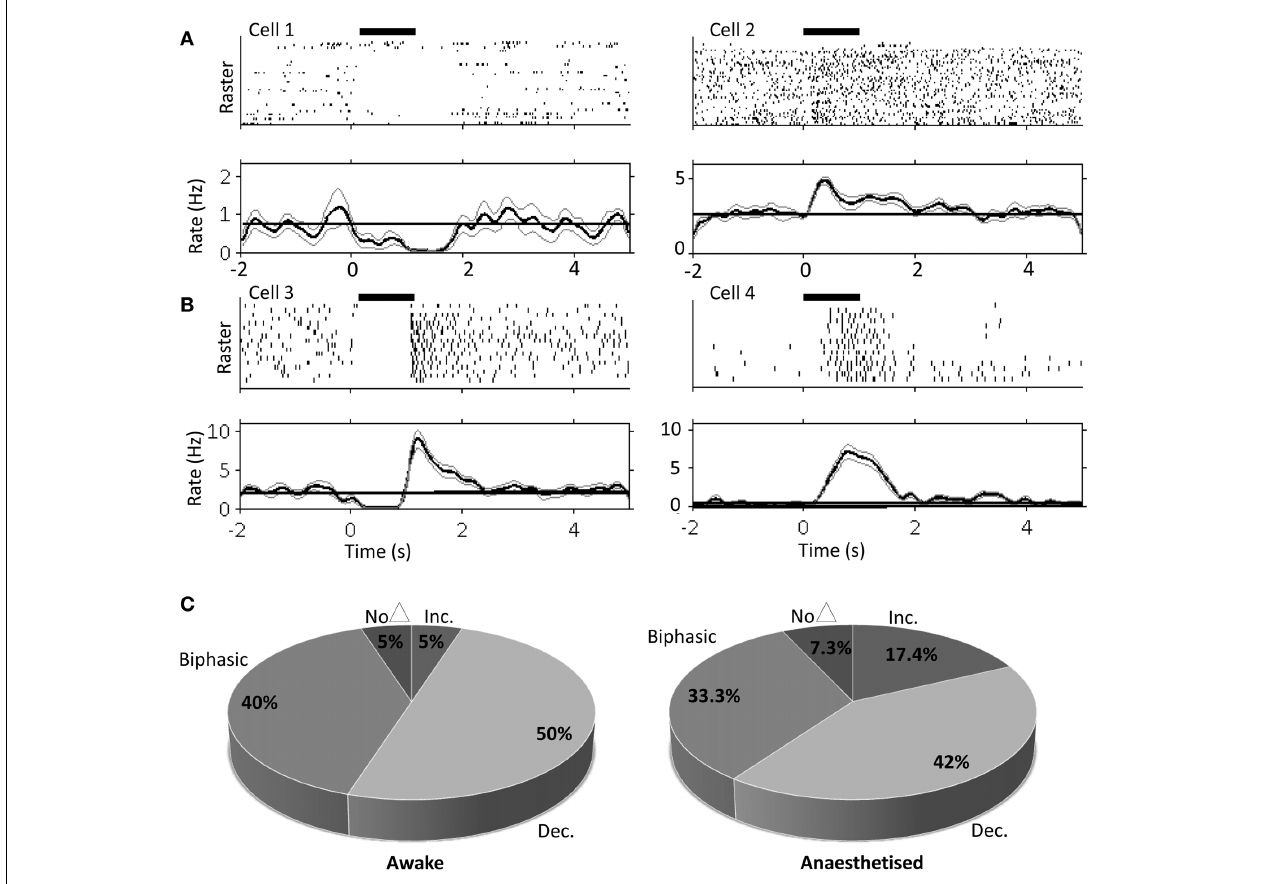
FIGURE 3 | Single unit PrL responses following FN stimulation in awake and urethane anesthetized rats. Raster and peri-stimulus rate plots for example cells recorded in PrL in the awake animal, cells 1 and 2 (A) and urethane anesthetized animal, cells 3 and 4 (B) . Horizontal black bar indicates duration of stimulation (100 μ A; 100Hz; 1s duration); bold line indicates instantaneous mean firing rate; gray lines